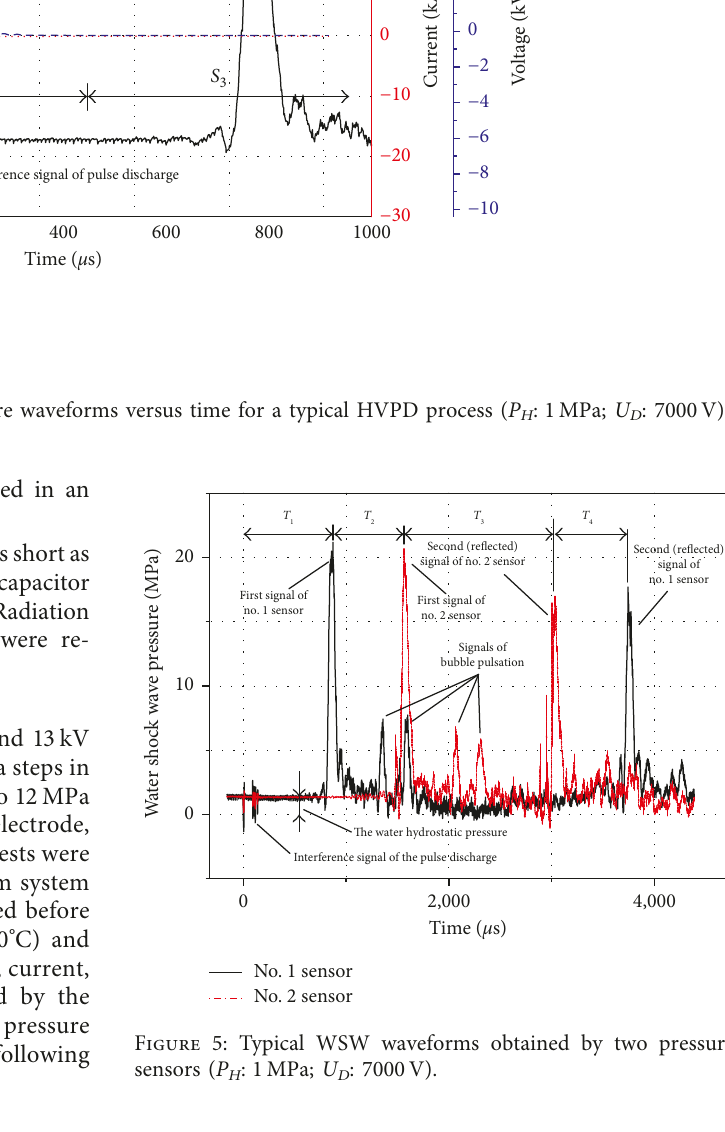
Figure 5: Typical WSW waveforms obtained by two pressure sensors ( P H : 1MPa; U D : 7000V).